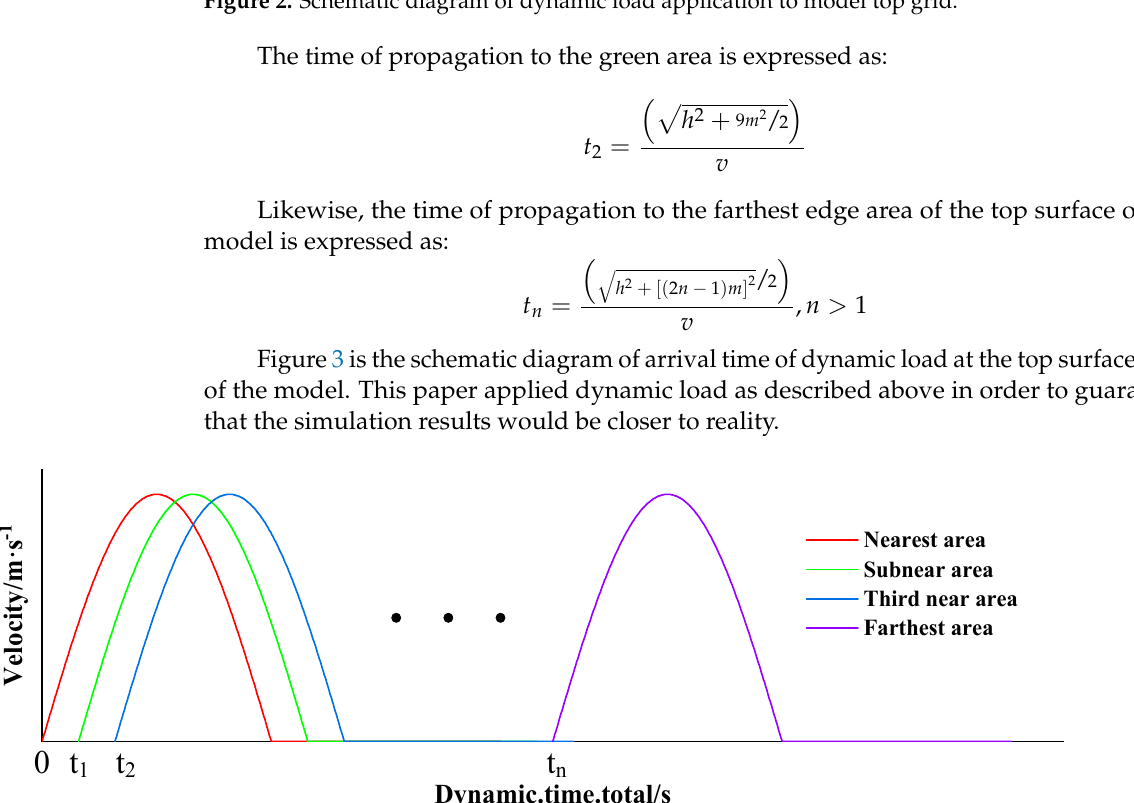
Figure 2. Schematic diagram of dynamic load application to model top grid. The time of propagation to the green area is expressed as: